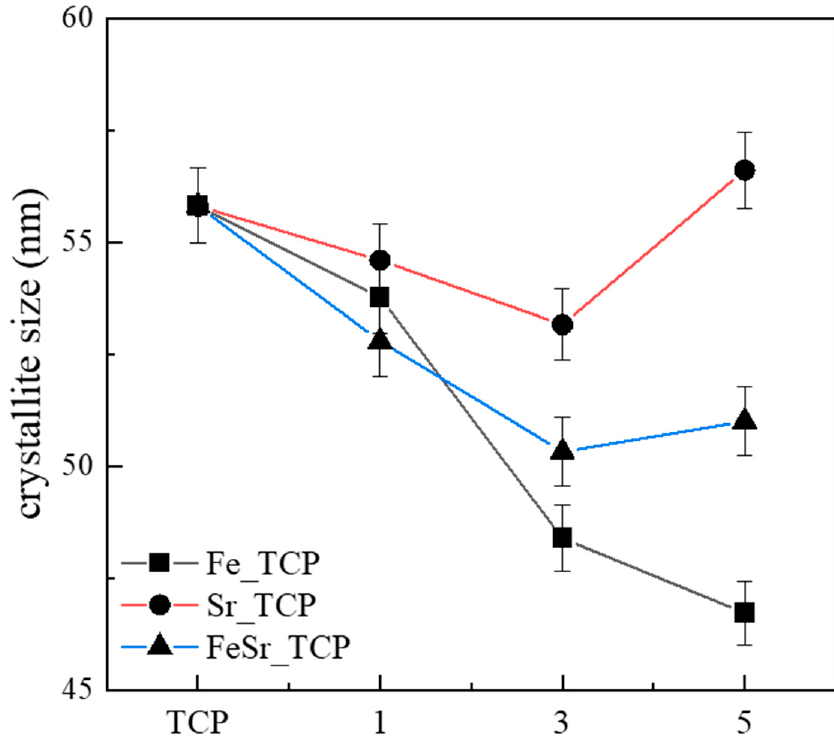
Figure 3. The variation of crystallite size for various β -TCP powders. Figure 4 is an SEM image of the β -TCP and the Fe/Sr co-substituted β -TCP powders. All samples were in the form of a uniform and partially agglomerated powder. Compared with the powder particle size of TCP, the Fe-substituted samples were smaller, and the Sr-substituted samples were similar or slightly increased. Fe/Sr co-substituted samples were slightly smaller than TCP and have complementary average particle sizes. As a result, it can be seen that the ions substituted for TCP also affect the powder particle size.